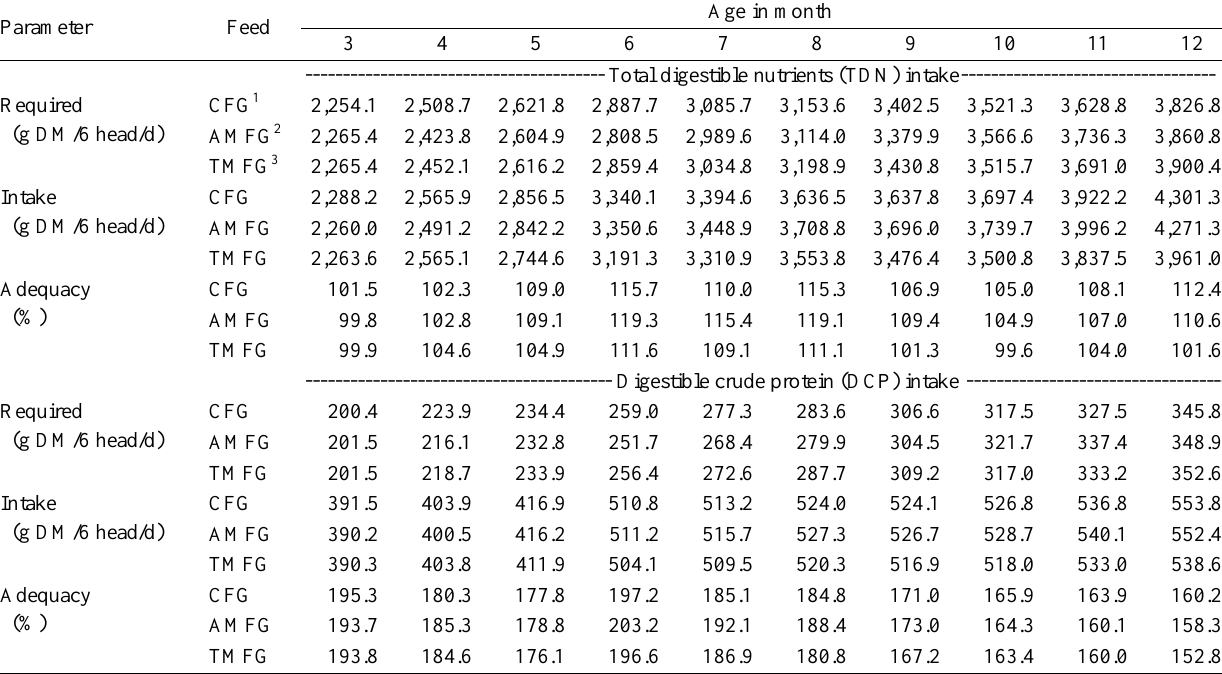
Table 6. Total digestible nutrients (TDN) and digestible crude protein (DCP) intake levels in the CFG, AMFG, and TMFG